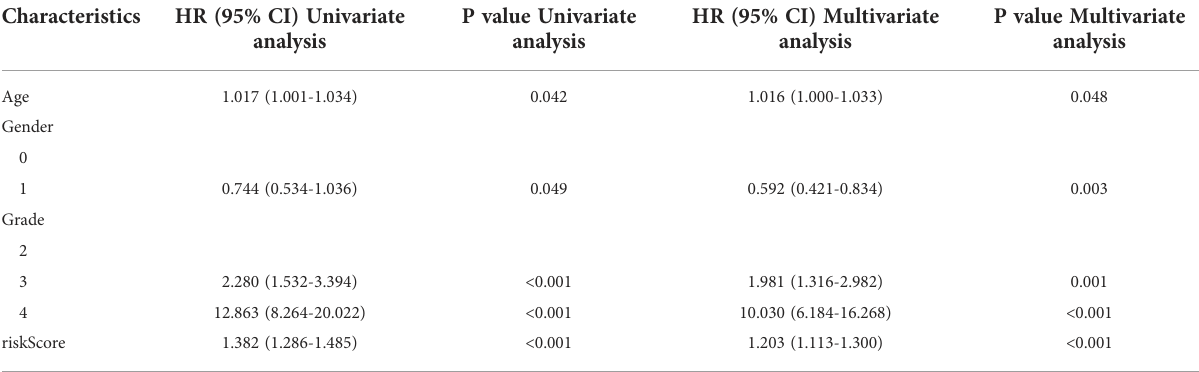
TABLE 2 Cox regression analysis of the immune